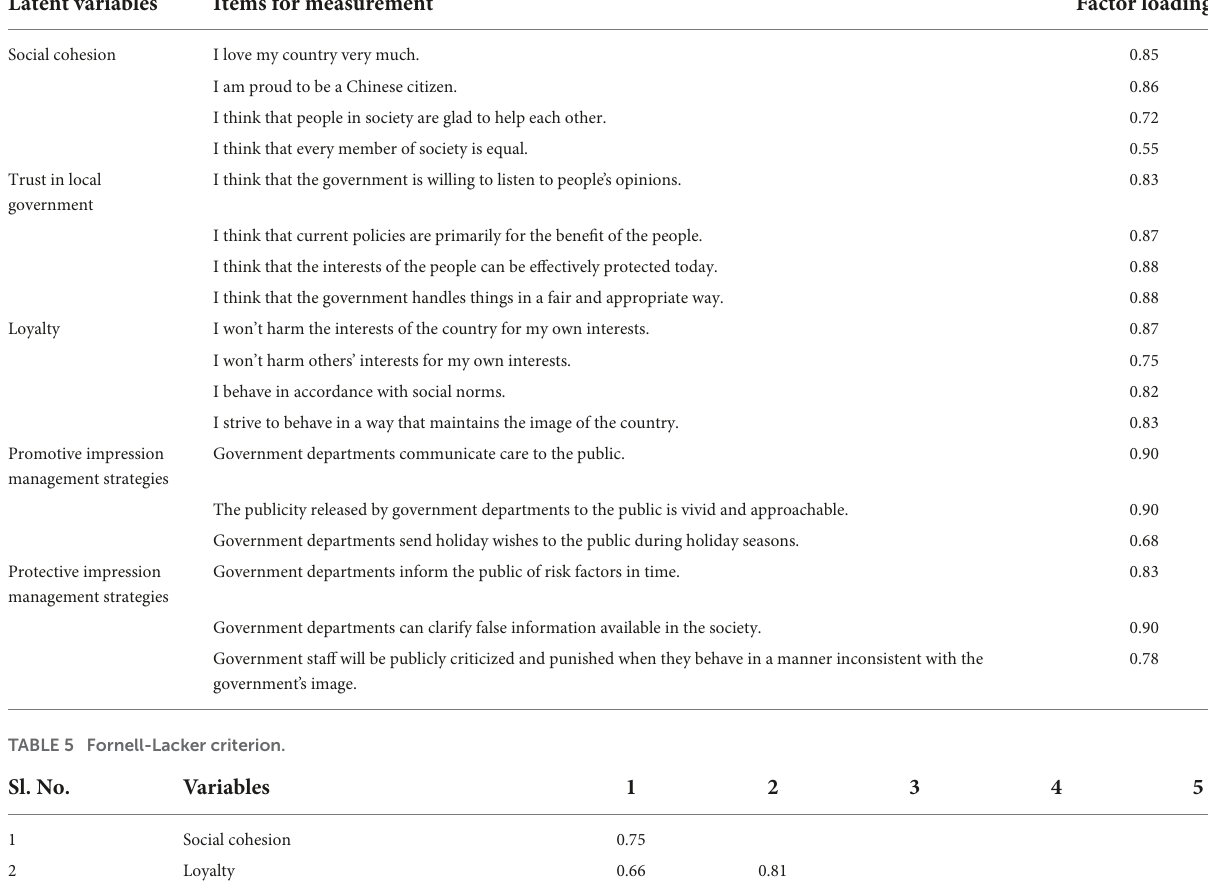
TABLE 4 Factor loading of all the constructs in this study.